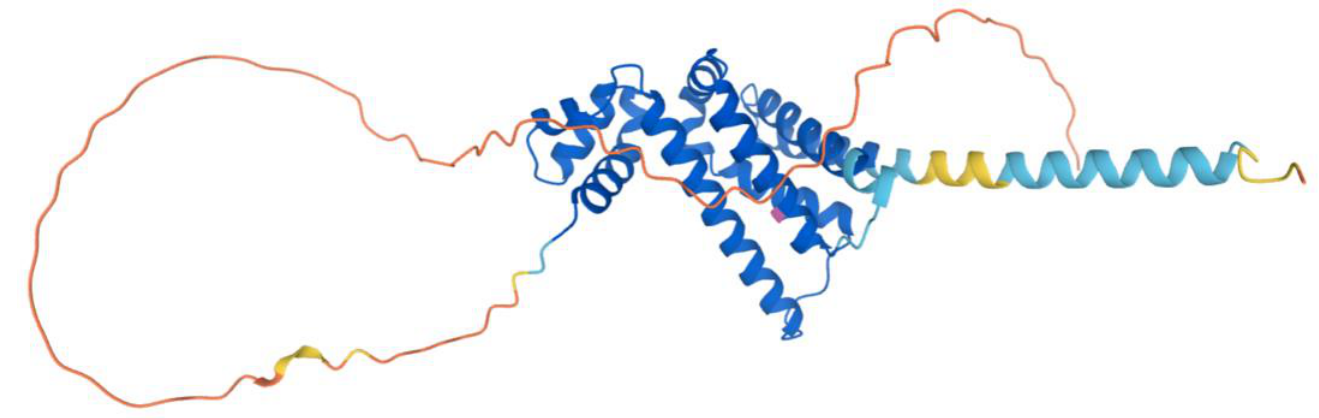
Figure A3. Structural alignment of the human COQ5 model (shown in orange) and the crystal struc- ture of S. cerevisiae Coq5, apo form (shown in teal, PDB: 4OBX). Residues 1 – 47 of the AlphaFold model were omitted due to disordered structure. Alignment was performed using PyMOL.